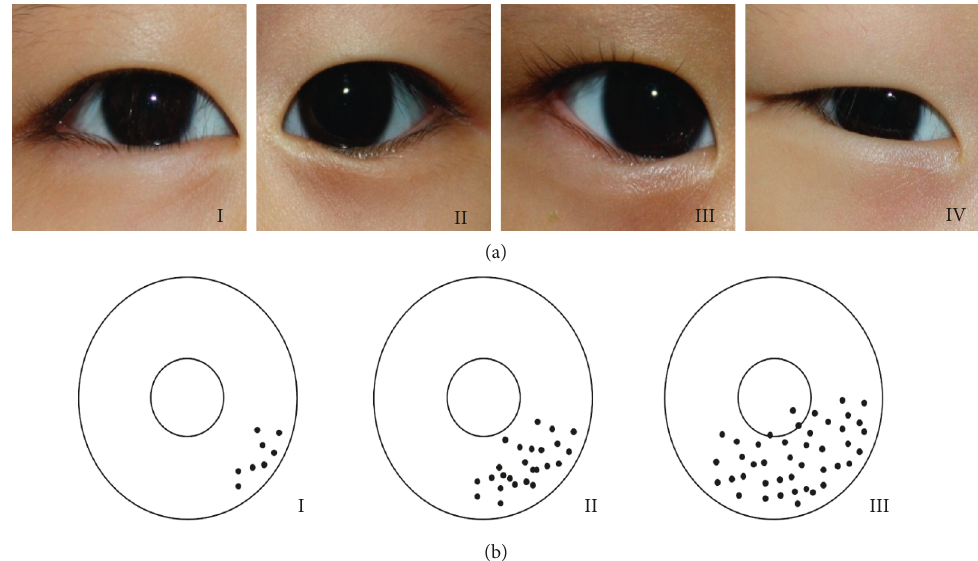
Figure 1: Preoperative classification of the lower lid epiblepharon according to the skin fold height: (a) The highest line of the horizontal skin fold below the lower lid margin was graded as class I, on the lower lid margin without concealment of the lid margin was graded as class II, above the lower lid margin with concealment of less than the medial one-third of the lid margin was graded as class III, and above the lower lid margin and concealing more than the medial one-third of the lid margin was graded as class IV. The grading of the cilia-corneal touch: (b) The cilia-corneal touch was class I if it was touching less than the medial one-third of the cornea; class II, less than the medial two- thirds of the cornea; class III, more than two-thirds of the